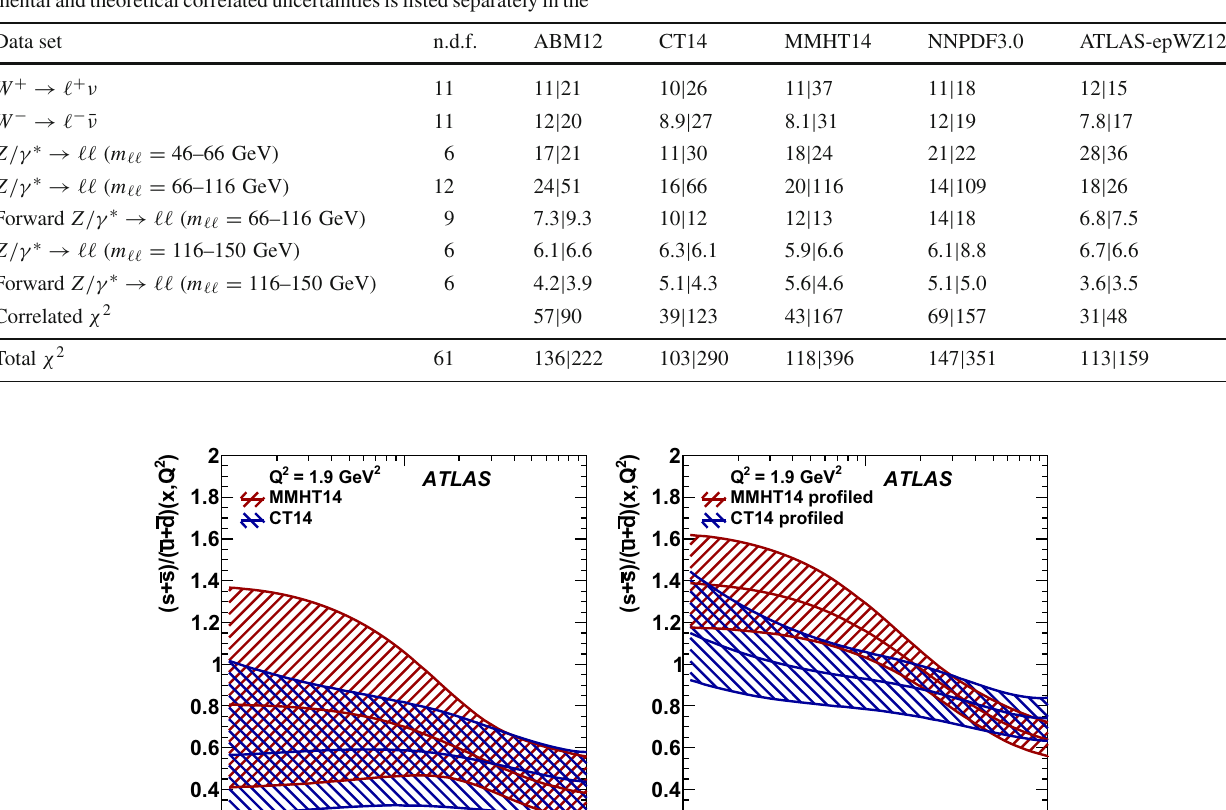
Table 17 Values of χ 2 for the predictions using various PDF sets split by data set with the respective number of degrees of freedom (n . d . f . ).